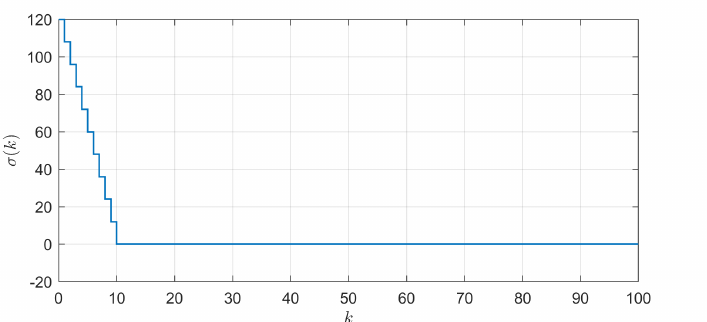
Figure 1. Sliding